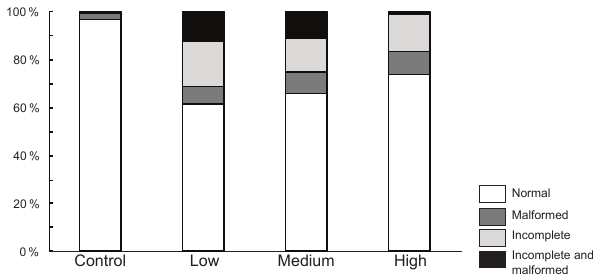
Figure 6. Malformation percentage. Percentages of normal, mal- formed, incomplete, and incomplete and malformed coccoliths of E. huxleyi versus trace metal concentrations.